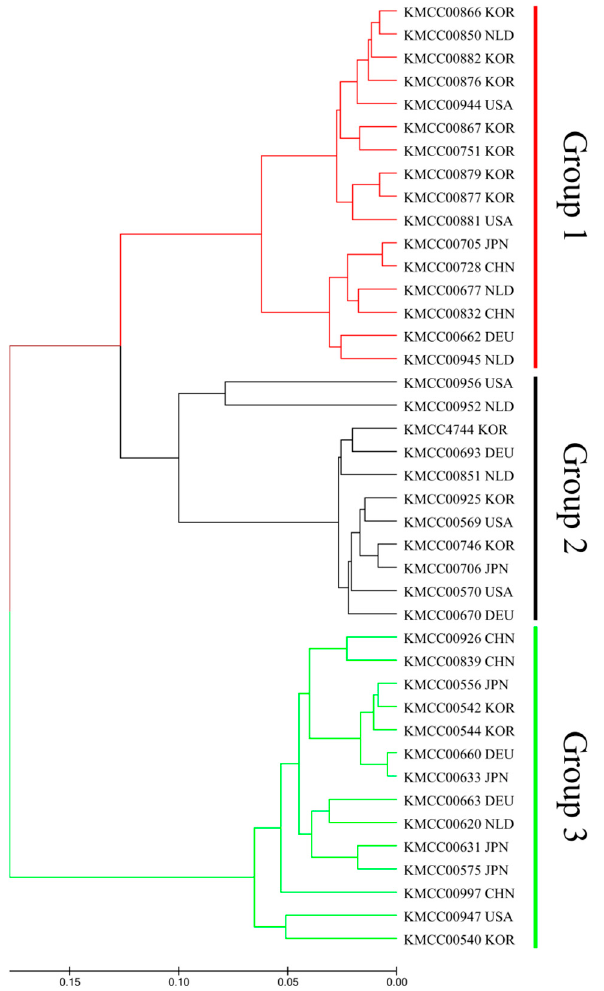
Figure 2. Phylogenetic tree constructed using the unweighted pair pop method with arithmetic mean based on Nei’s genetic distance.